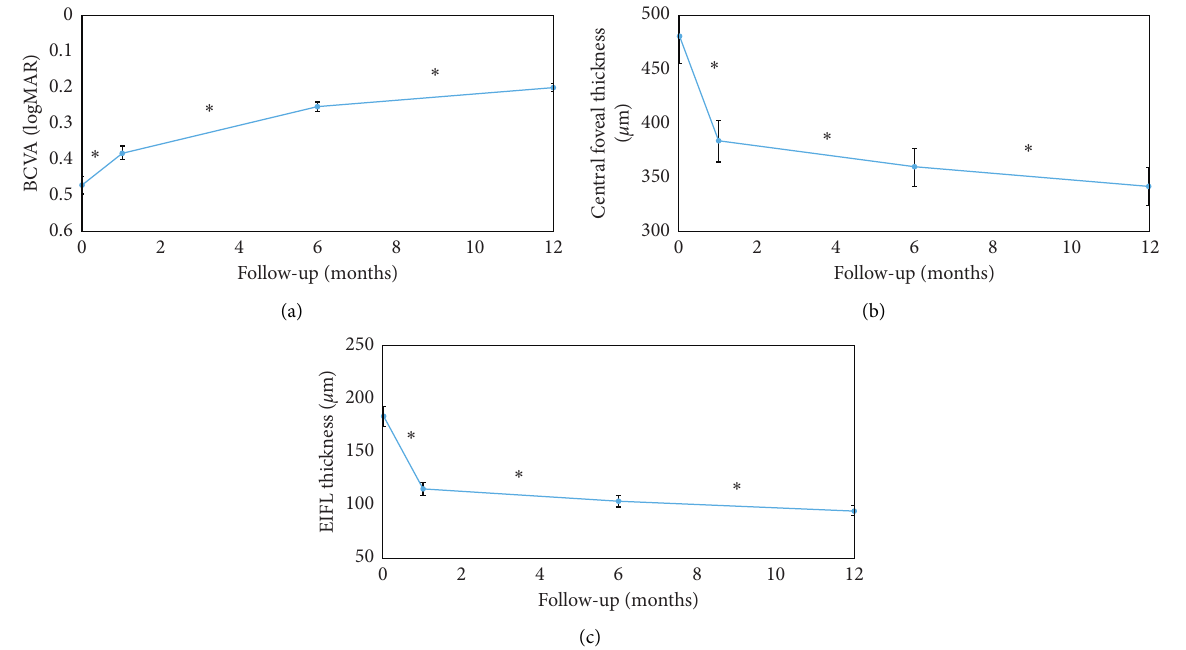
Figure 3: Functional and anatomical changes occurring from baseline to the 12 months postoperatively. (a) The best-corrected visual acuity (BCVA) significantly improved in the postoperative follow-up period ( p < 0 . 001 ) . (b) In the follow-up period, the central foveal thickness (CFT) decreased significantly with a noticeable effect at 1 month after surgery ( p � 0 . 001 ) . (c) Similar to the CFT, the thickness of the ectopic inner foveal layers (EIFLs) decreased significantly with a prominent effect in the first month after surgery ( p � 0 . 003 ) .